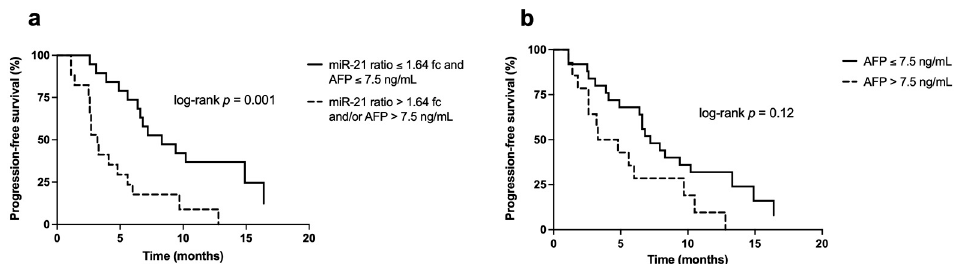
Figure 4. Kaplan–Meier curves for the PFS in patients with favorable radiological response (CR and PR). ( a ) Survival curves according to the combined evaluation of miR-21 ratio and AFP levels. Patients with both markers below their respective cut-offs achieved a statistically significant longer PFS compared to patients with at least one marker above its prognostic cut-off (8.3 months [6.4–16.4] in patients with miR-21 ratio ≤ 1.64 fc and AFP ≤ 7.5 ng/mL vs. 3.3 months [2.5–6.0] in the comparator group; p = 0.001); ( b ) survival curves of AFP alone in patients with CR and PR. Despite demonstrating a longer median PFS, patients with AFP ≤ 7.5 ng/mL had not a statistically significant higher survival compared to patients with AFP <7.5 ng/mL (7.2 months [4.1–13.3] vs. 4.1 months [2.6–9.7], respectively; p = 0.12).